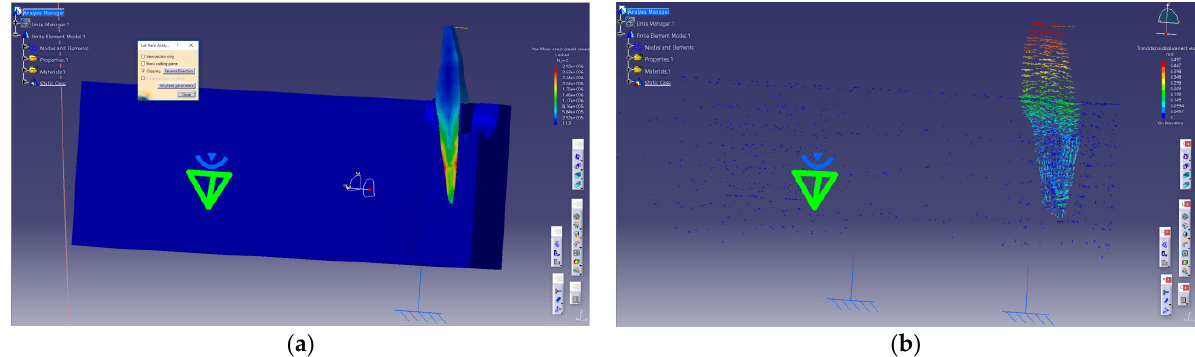
Figure 2. Lingualization of the LCI using a 1 N force: ( a ) von Mises tensions, no HBL; ( b ) tooth movement obtained, no HBL.